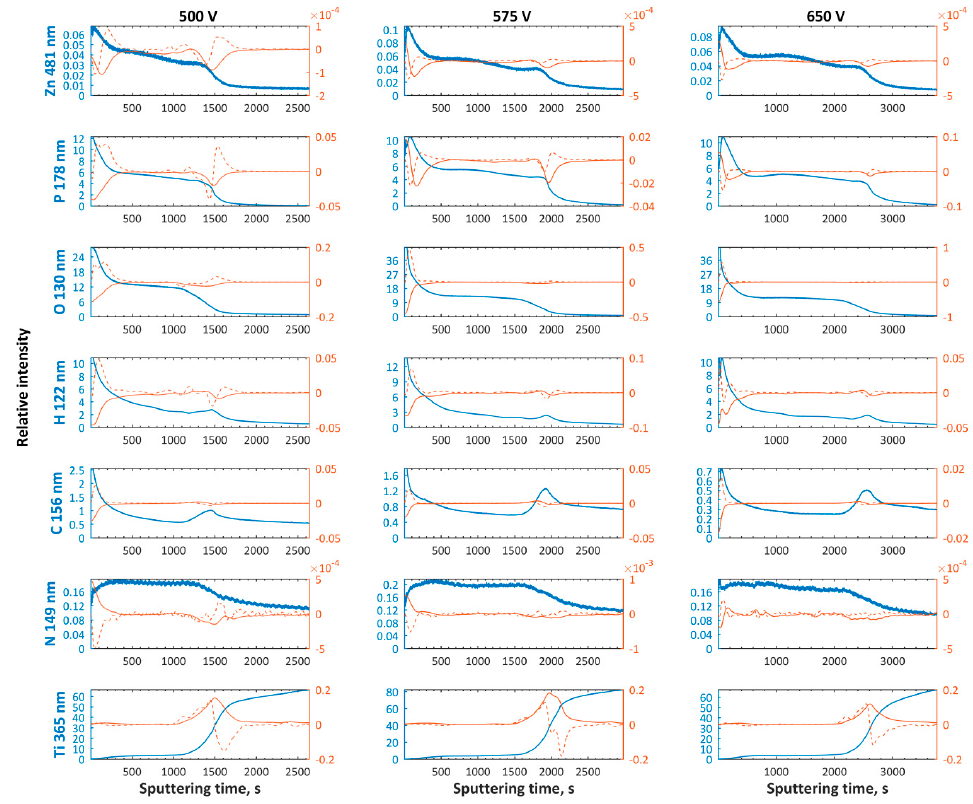
Figure 6. Glow discharge optical emission spectroscopy (GDOES) signals of zinc (Zn), phosphorus (P), oxygen (O), hydrogen (H), carbon (C), nitrogen (N), and titanium (Ti) of the porous coating formed on CP Titanium Grade 2 after PEO treatment at voltages of 500 V DC , 575 V DC , and 650 V DC in 500 g·L − 1 Mg(NO 3 ) 2 ·6H 2 O in H 3 PO 4 electrolyte; blue continuous line—GDOES signal, red continuous line—first derivative, red dotted line—second derivative.